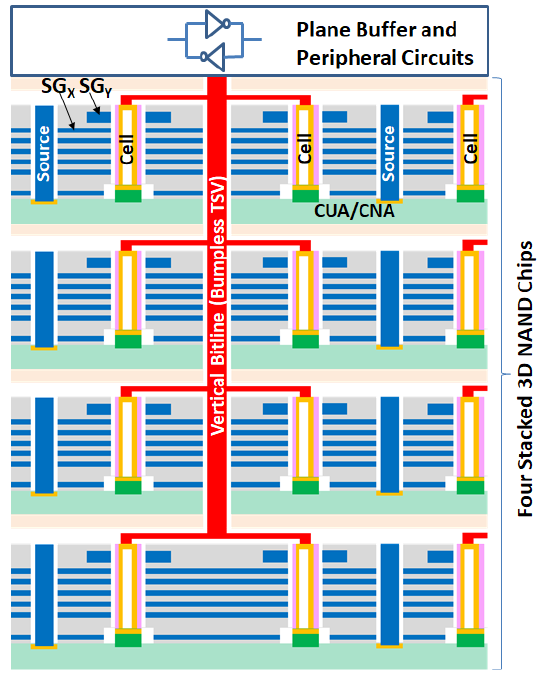
Figure 42. Four 3D NAND chips connected through Vertical BL.